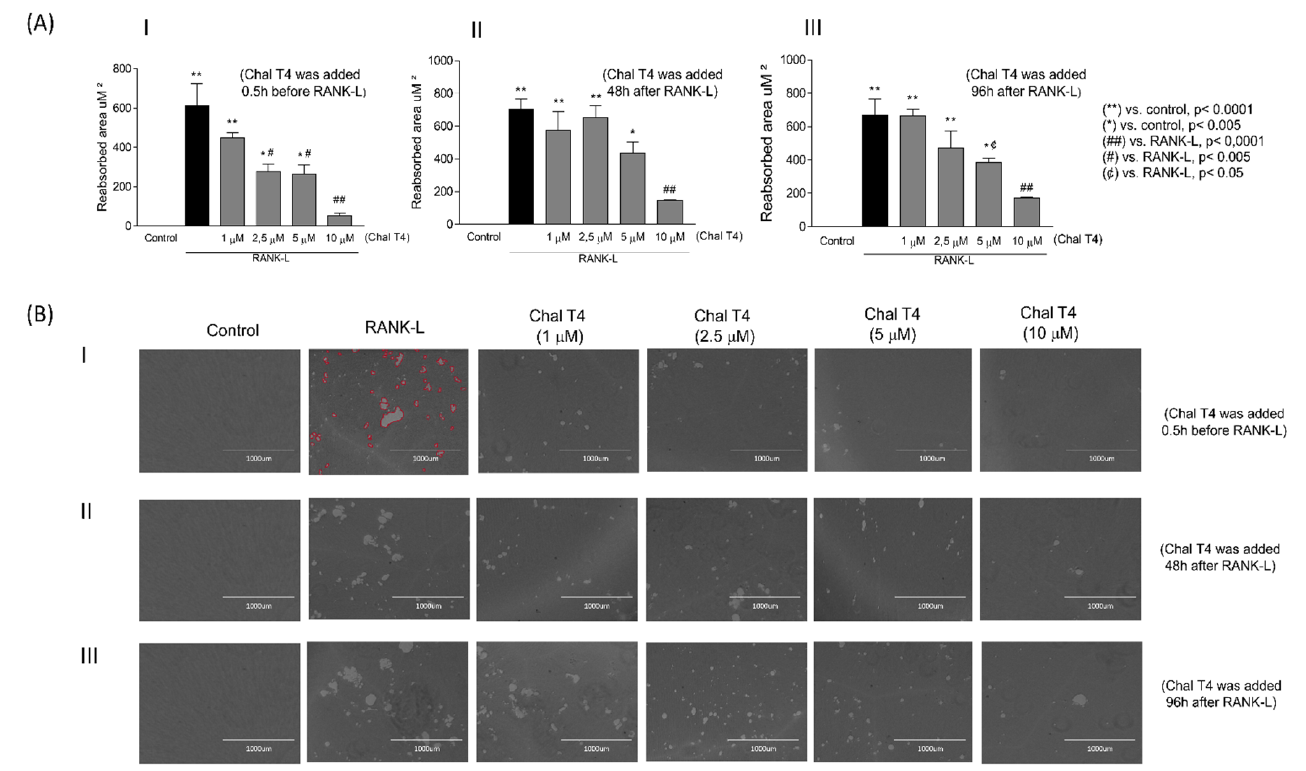
Figure 2. Chalcone T4 inhibits osteoclast activity in a dose-dependent manner, in all analyzed periods. Cells were stimulated with RANKL and treated with chalcone as described above. The resorptive activity of osteoclasts was evaluated through the area of the resorption gaps (underlined in red) in the plates coated with synthetic calcium phosphate. ( A ) ( I – III ) quantitative result of the area reabsorbed by osteoclasts, in the different periods of chalcone addition. ( B ) ( I – III ) representative images of the area of resorption after stimulation of cells with RANKL and treatment with the compound (4 × magnification). The bars indicate the mean values and the vertical lines the standard error of the mean (SEM) of three different experiments evaluated in triplicate. Statistically significant differences between groups, as well as p values are indicated in the fi gure.